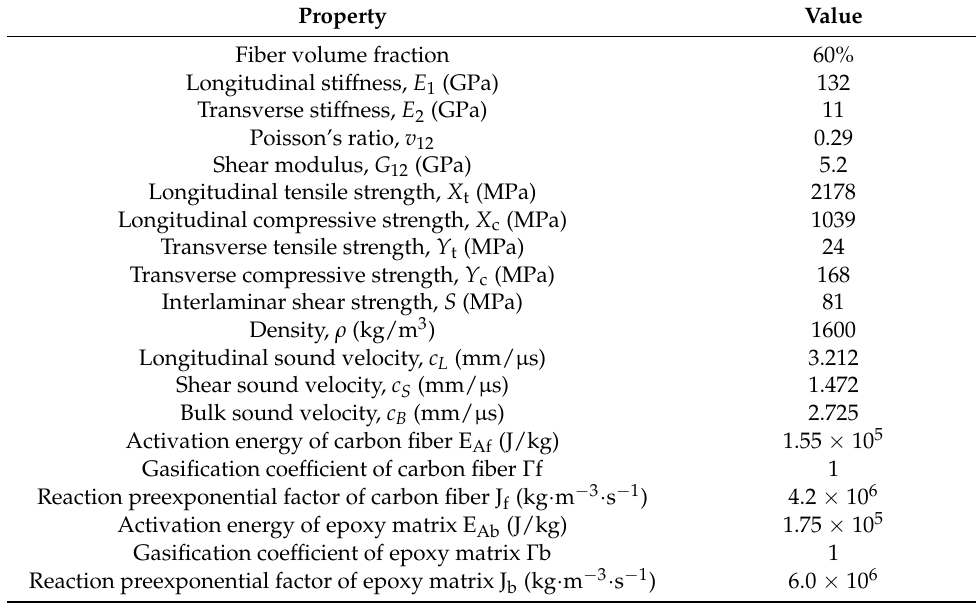
Table 1. Material properties of the CFRP